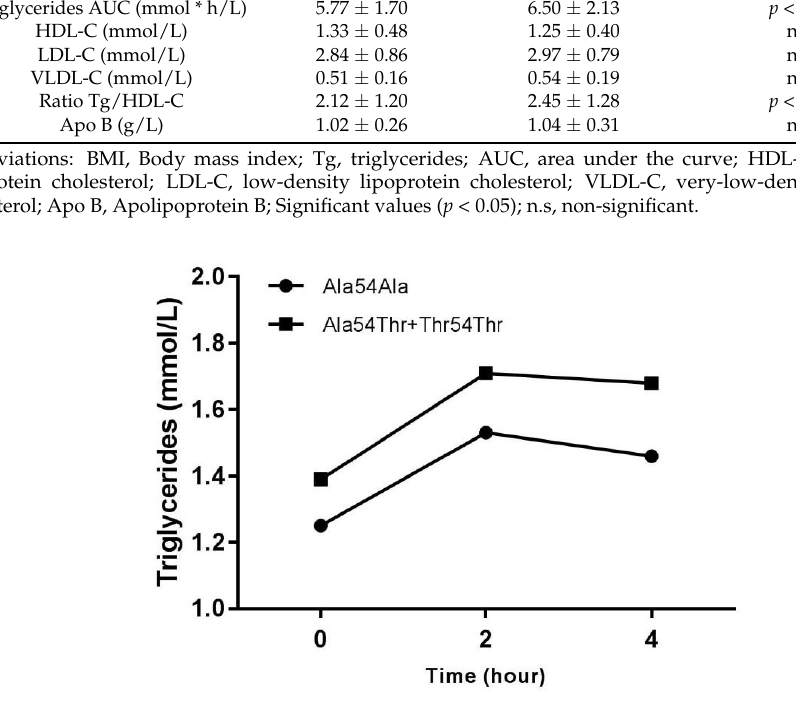
Table 3. Biochemical parameters according to FABP2 genotype.